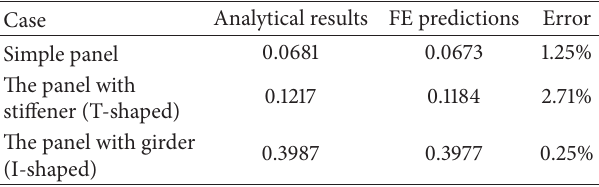
Table 2: Analytical and FE predictions of normalized